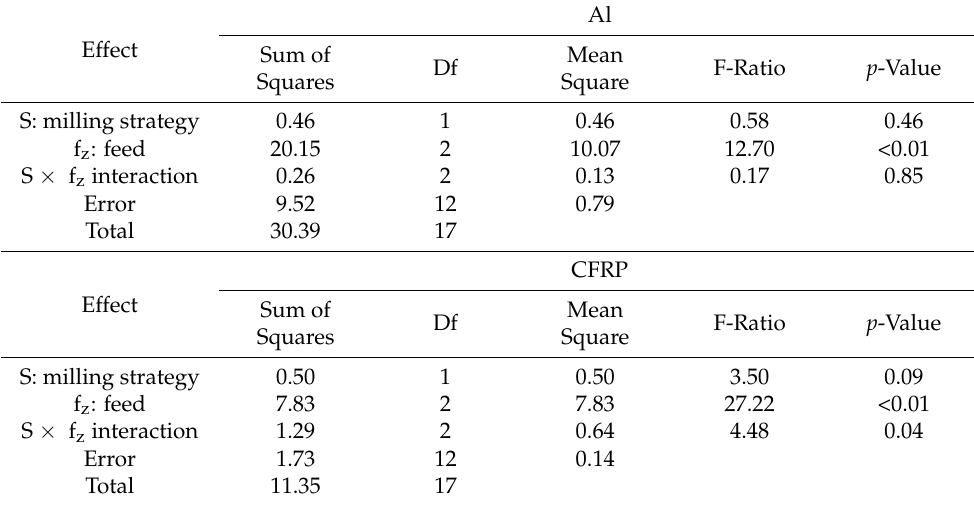
Table 2. ANOVA variance analysis results for the Rz surface roughness